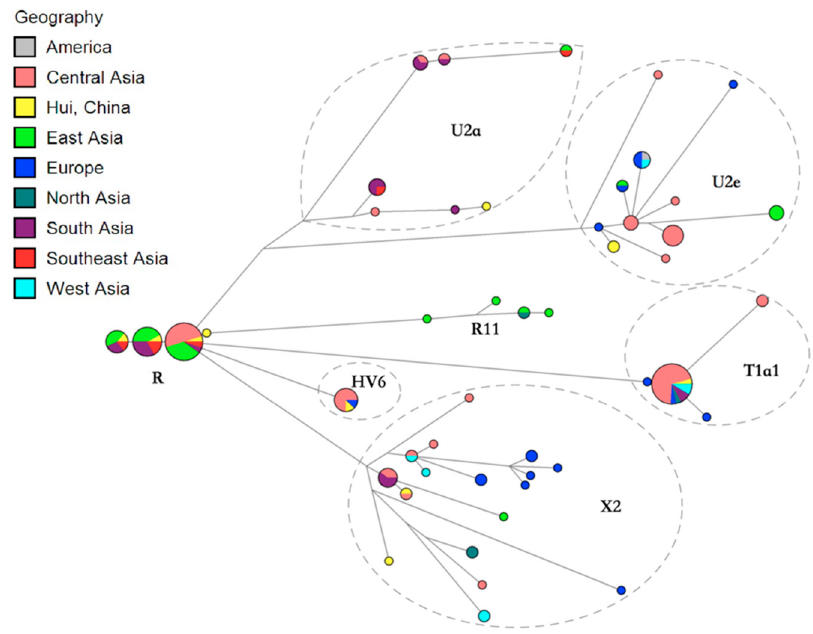
Figure 6. The median network of European-specific lineages appearing in Hui group coupled with reference individuals from worldwide populations. The size of the nodes is proportional to the number of individuals carrying that node. The length of the branch is positively correlated with the number of different mutations, the longer the branch, the more different the mutations.